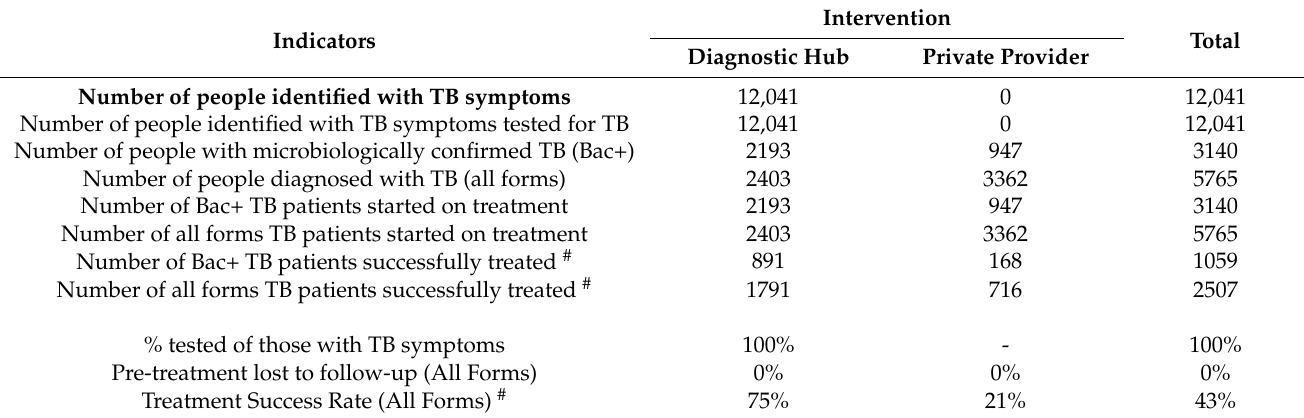
Table 3. Outcomes in the private project disaggregated by intervention between July 2017 and December 2018. Indicators